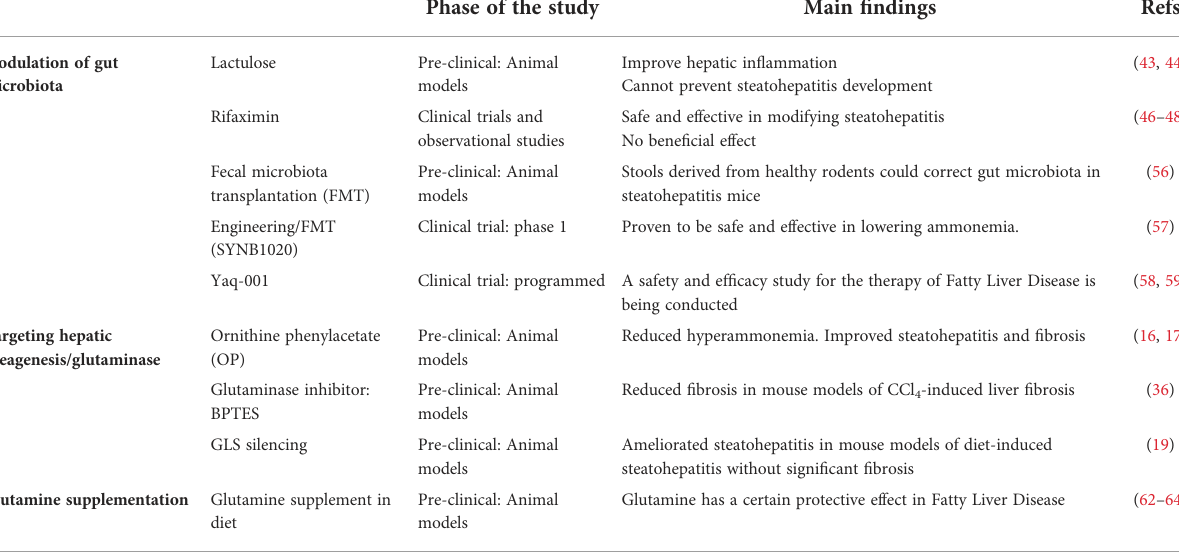
TABLE 1 Current therapeutic approaches modulating nitrogen metabolism in pre-clinical and clinical studies in Fatty Liver